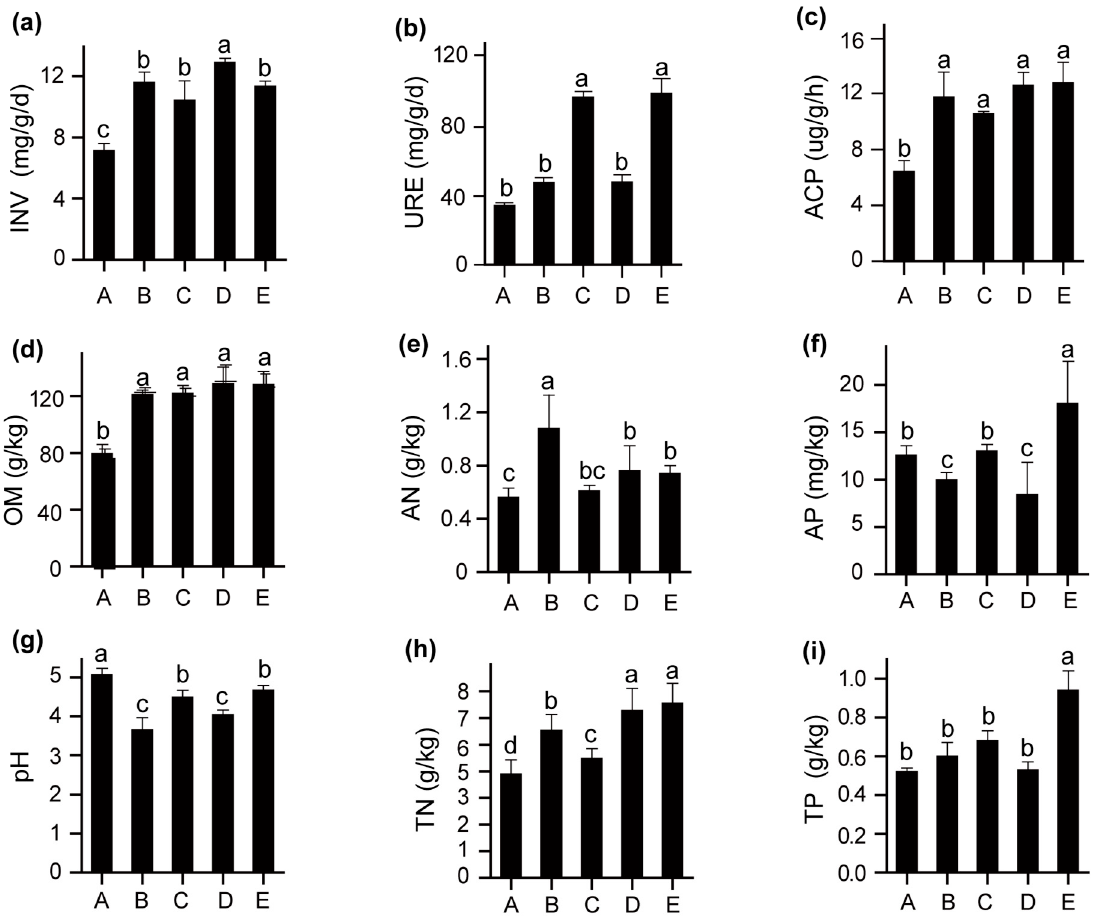
Figure 1. Soil enzyme activity and soil chemical properties. ( a ), INV, Invertase activity; ( b ), URE, urease activity; ( c ), ACP, acid phosphatase activity; ( d ), OM, organic matter content; ( e ), AN, available N content; ( f ), AP, available P content; ( g ), pH value; ( h ), TN, total N content; ( i ), TP, total P content. A, Cyclobalanopsis kerrii (Craib) Hu, 1911 forest; B, the lower range limit of Cephalostachyum pingbianense (Hsueh & Y.M. Yang ex Yi et al.) D.Z. Li & H.Q. Yang, 2007 forest; C, the range center of C. pingbianense forest; D, the upper range limit of C. pingbianense forest; E, Lithocarpus glaber (Thunb.) Nakai, 1916 forest. Different letters (a, b, c, d) meant significant differences at the 0.05